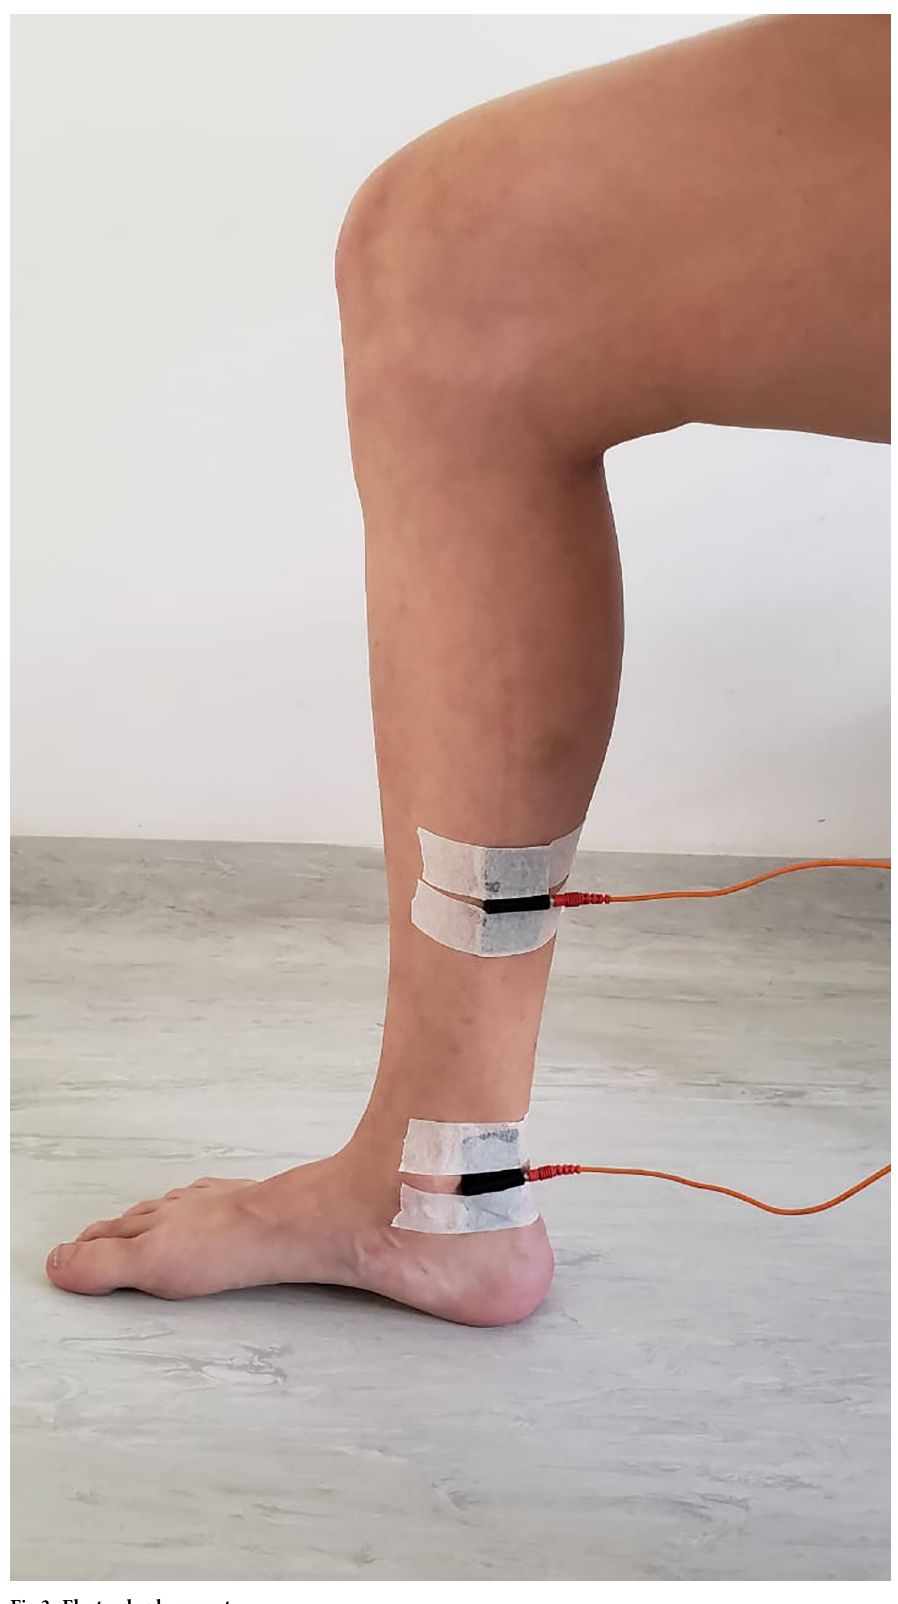
Fig 3. Electrode